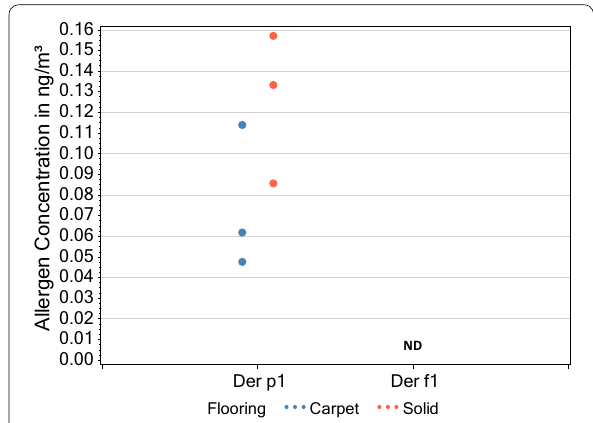
Fig. 5 Comparison of measurable (above the LoD) mite allergen airborne concentrations in lounges with carpets and those with solid flooring (Respective carpet and solid flooring sample sizes (n) were 3 and 3 for Der p1) Statistical analysis (T-test unpaired 2 t-tailed) com- paring carpet and solid flooring measurable values gave a P-value of 0.152 for Der p 1. ND not detected above the =